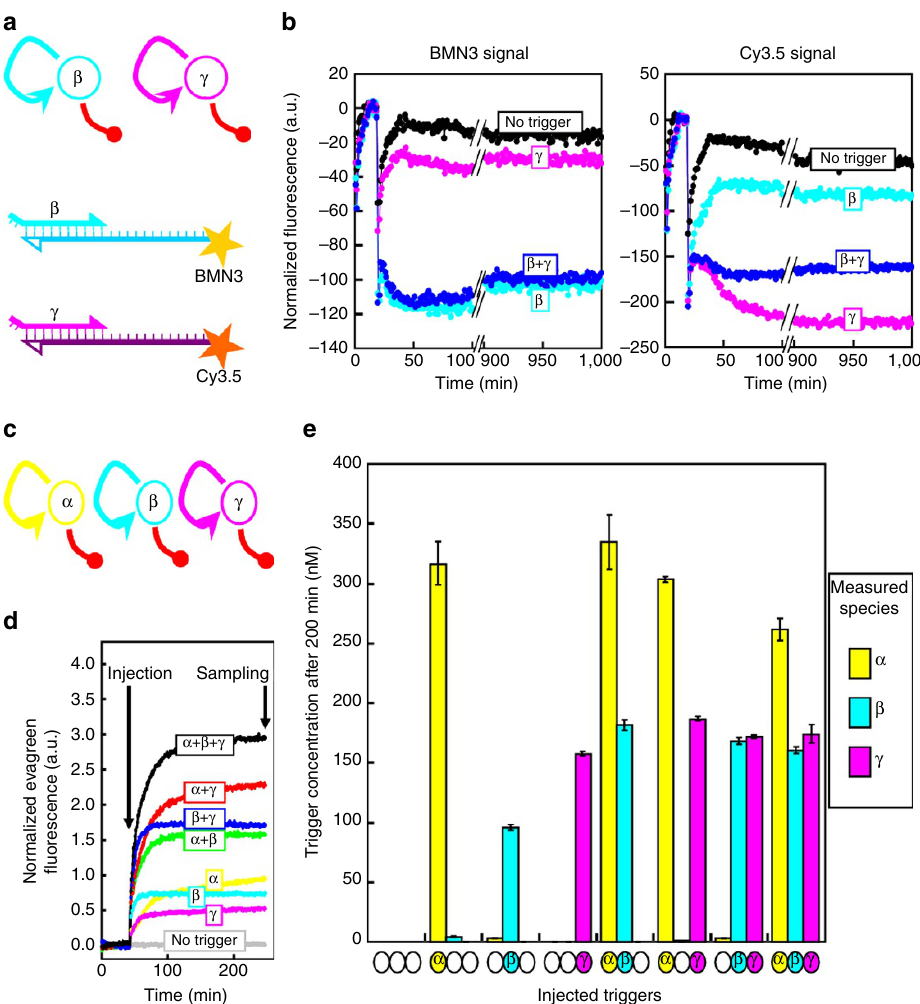
Figure 7 | Multistable memory units. ( a ) A two-bit system can be constructed by combining two bistable networks with orthogonal sequences, as schematized, and monitored with two fluorescent dyes attached to the templates 25 . ( b ) Change over time of BMN3 and Cy3.5 fluorescence after injection of the four possible combinations of the two triggers (no trigger; b only; g only; b and g ). ( c ) Similarly, a three-bit system is obtained from three orthogonal nodes. ( d ) A mixture of a to a 3, b to b , g to g , drain a 1, drain b and drain g was triggered with the eight possible combinations of their respective trigger (indicated in the coloured boxes) and EvaGreen fluorescence was monitored for 200min. The nonspecific fluorescence signal suggests that steady states with one, two or three active nodes are attained. ( e ) The reaction in each tube from ( d ) was quenched after 200min and the concentration of a , b and g in the mixture were independently measured (see Methods). Only the nodes that had been triggered appeared to be in the high state, while untriggered ones were still in the low state. Each plot shows the mean concentration ± s.d. from two